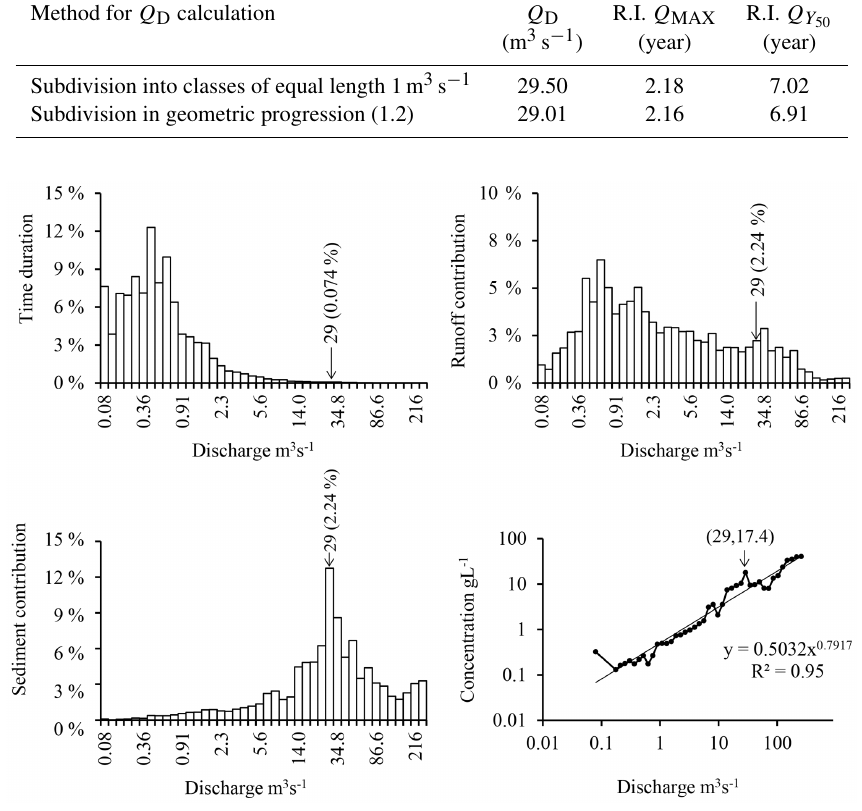
Figure 7. Duration, water and sediment input per class, as well as sediment rating curves, for the subdivision into classes of geometric progression of common ratio